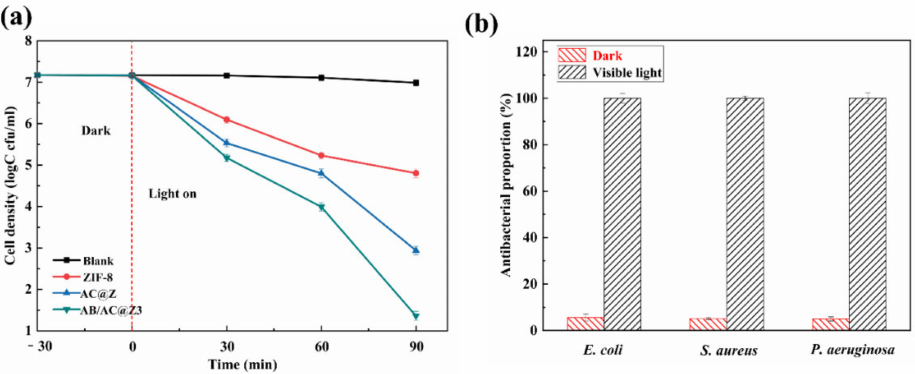
Figure 7. ( a ) Survival curves of E. coli treated with different catalysts under visible light. ( b ) Total percentage of inactivation of E. coli , S. aureus , and P. aeruginosa by AB/AC@Z3 under dark and light